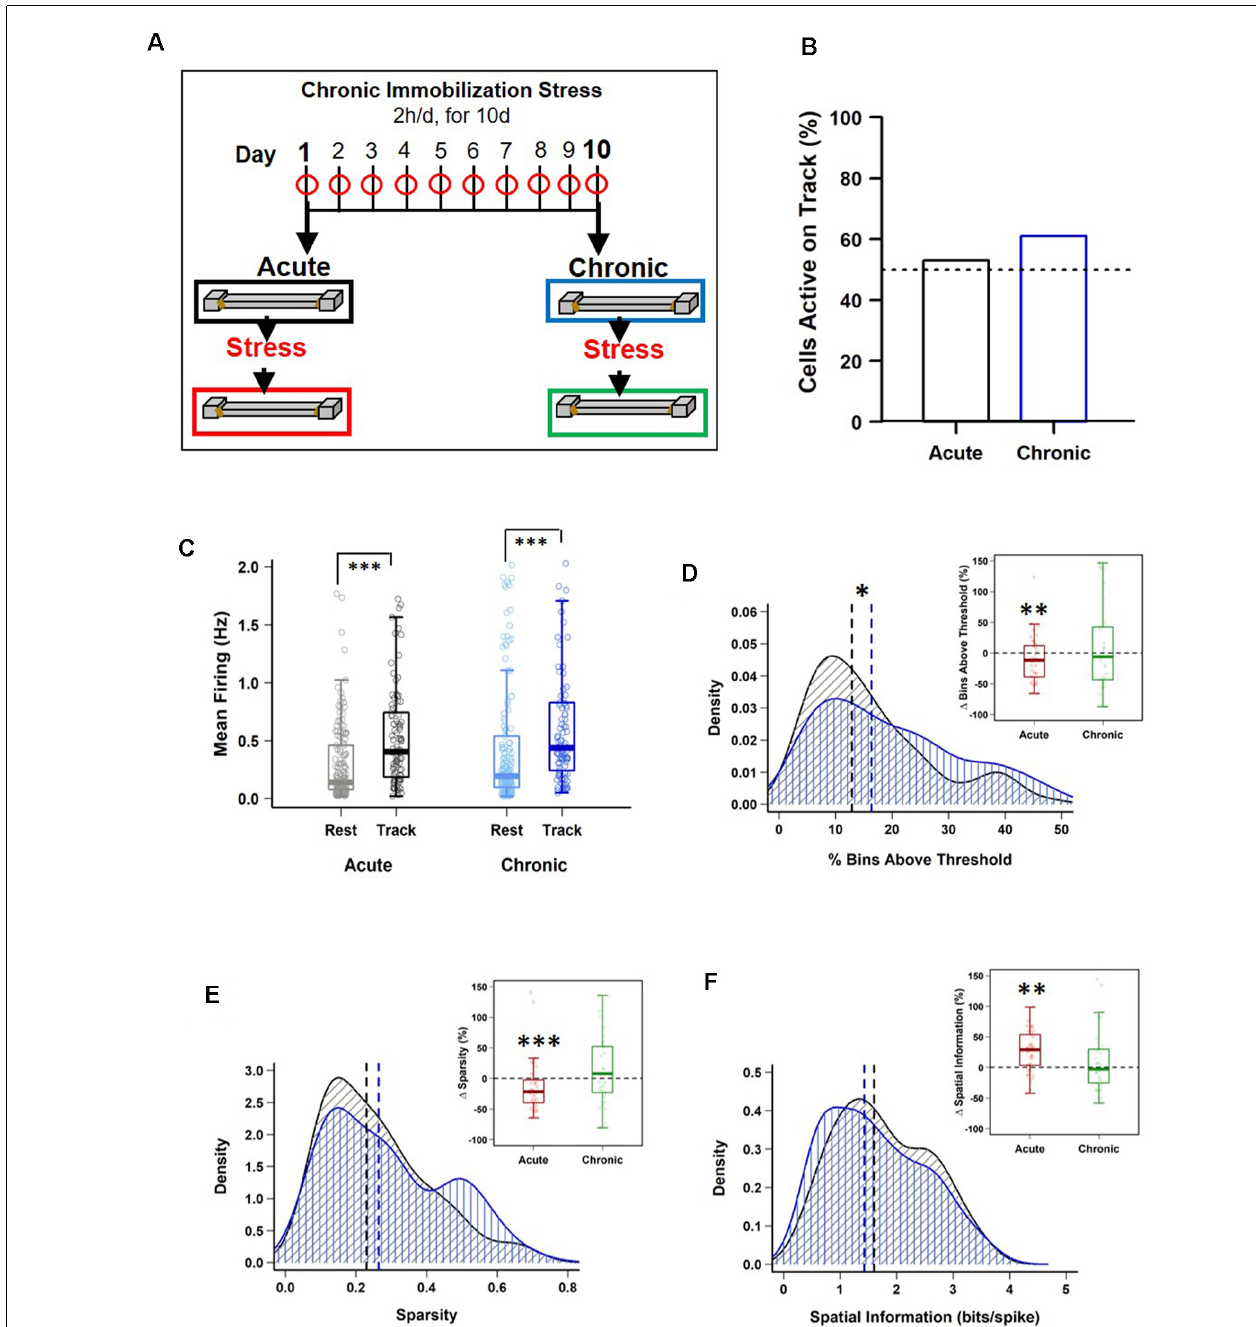
FIGURE 1 | Impact of stress on CA1 place cell activity. (A) Schematic representation of the chronic immobilization stress (CIS) protocol and experimental design. (B) Percentage of pyramidal cells active during exploration (RUN) compared to quiet wakefulness/sleep (REST) period, before stress administration (Pre-stress), on day-1 (black) and day-10 (blue), [day-1: 95/180 (53%) vs. day-10: 101/166 (61%), p = 0.164, chi-square test]. Dotted line represents 50%. (C) Pre-stress mean firing rates between REST and RUN on day-1 and day-10 [LMMs: main effect of day, F (1,538) = 3.988, p = 0.046; main effect of session, F (1,538) = 64.02, p = 7.708 × 10 − 15 ; interaction, F (1,538) = 0.018, p = 0.892; post hoc Tukey’s test, day-1: REST ( n = 180) vs. RUN ( n = 95), p < 0.0001, day-10: REST ( n = 166) vs. RUN ( n = 101), p < 0.0001]. (D) Pre-stress place field size density distribution differs between day-1 and day-10 (PRE-Acute ( n = 95) vs. PRE-Chronic ( n = 101), p = 0.049, KS-test). However, place cells active during RUN, before and after stress exposure, display a decrease in field size on day-1 (PRE-Acute 13.89 ± 1.46 vs. POST-Acute, 11.25 ± 0.96, V = 280, p = 0.009, Wilcoxon signed-rank test, n = 36) but not on day-10 (PRE-Chronic, 19.71 ± 2.39 vs. POST-Chronic, 17.81 ± 1.99, V = 186, p = 0.316, Wilcoxon signed-rank test, n = 34). (E) Pre-stress sparsity of place fields does not differ